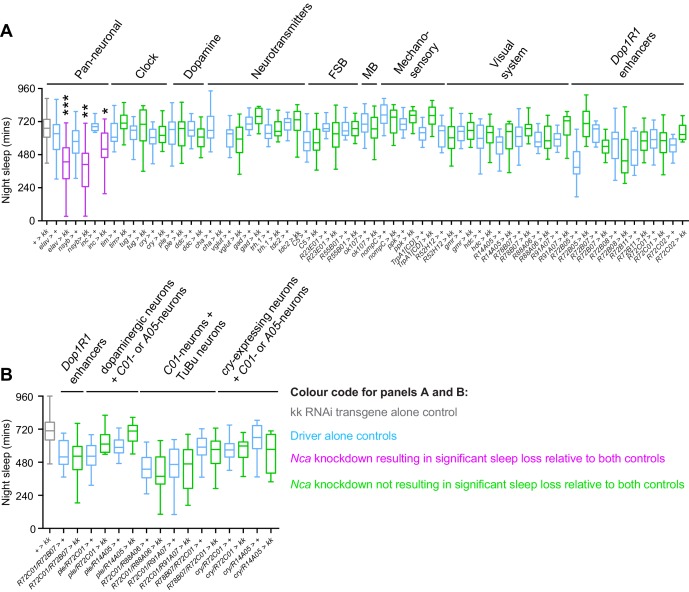
Transgenic RNAi-based mini-screen to identify key NCA-expressing neurons.(A) Nca knockdown with broadly expressed drivers resulted in reduced night sleep in adult males under 8L: 16D conditions. In contrast, Nca knockdown in previously defined sleep-regulatory centers, clock neurons, the visual system or subsets of Dop1R1-expressing neurons did not impact night sleep. FSB: fan-shaped body. MB: mushroom body. Grey and blue box plots: control lines. Magenta box plots: experimental lines showing reduced night sleep relative to controls. Green box plots: experimental lines failing to show reduced night sleep relative to one or both controls. Grey box plot: kk Nca RNAi alone (+ > kk) controls. Blue box plots: Gal4 driver heterozygotes. (B) Nca knockdown using combinations of driver lines labelling C01- and A05-neurons in addition to neurons in the dopaminergic pathway (dopamine-release and Dop1R1-expressing neurons), the anterior visual pathway (tubercular-bulbar (TuBu) neurons), and cryptochrome (cry)-expressing neurons. See Figure 4 Source Data for n-values and additional statistical comparisons. *p<0.05, **p<0.01, ***p<0.001, as compared to driver and RNAi alone controls via Kruskal-Wallis test with Dunn’s post-hoc test.